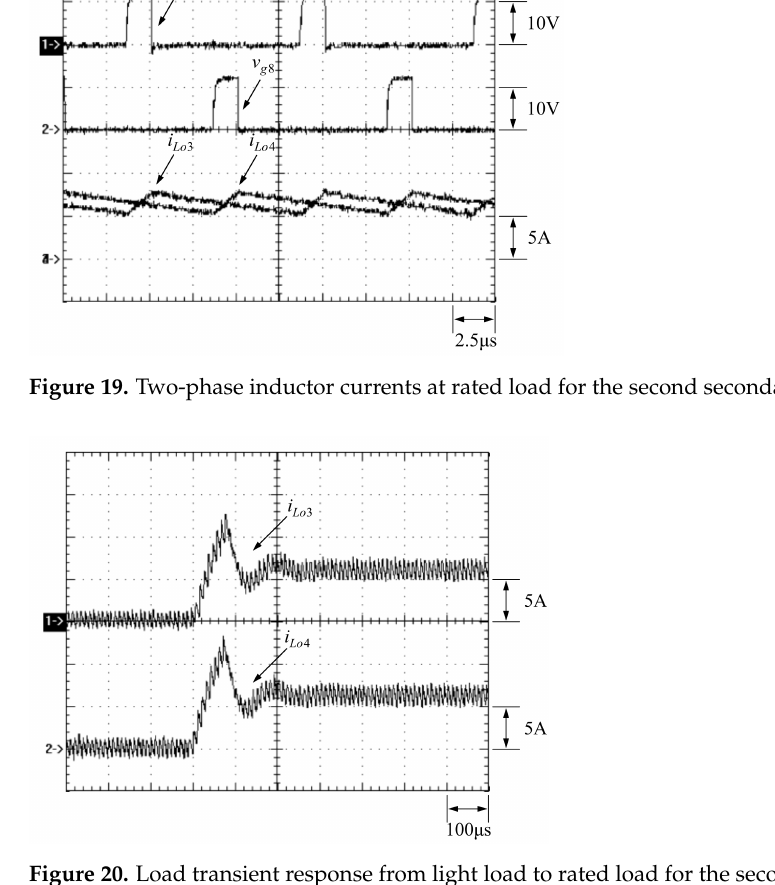
Figure 20. Load transient response from light load to rated load for the second secondary output.